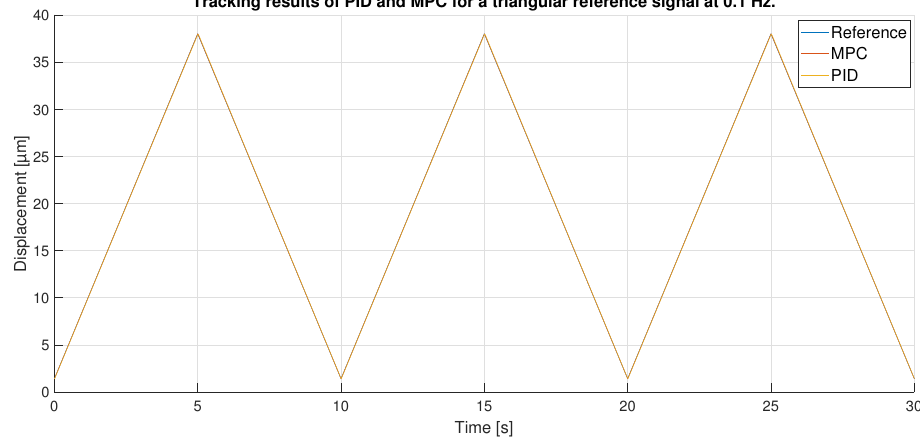
Figure 11. Tracking results of PID and MPC for a triangular reference signal at 0.1 Hz.